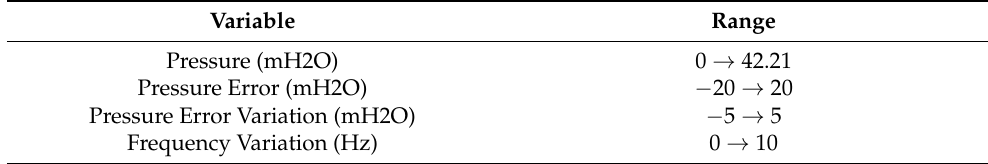
Table 1. Ranges related to each variable.